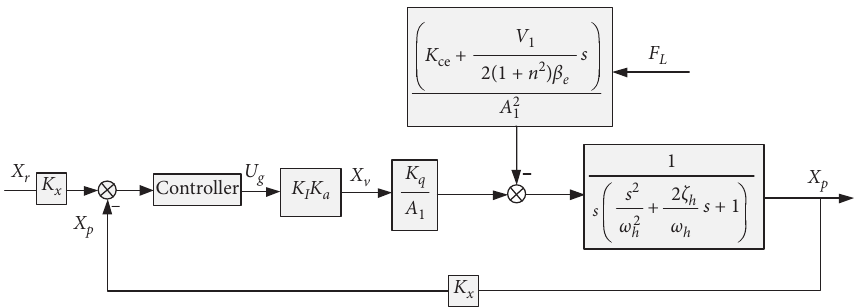
Figure 3: Block diagram of the linearized HDU position control Table 2: Parameters of different reaching laws.